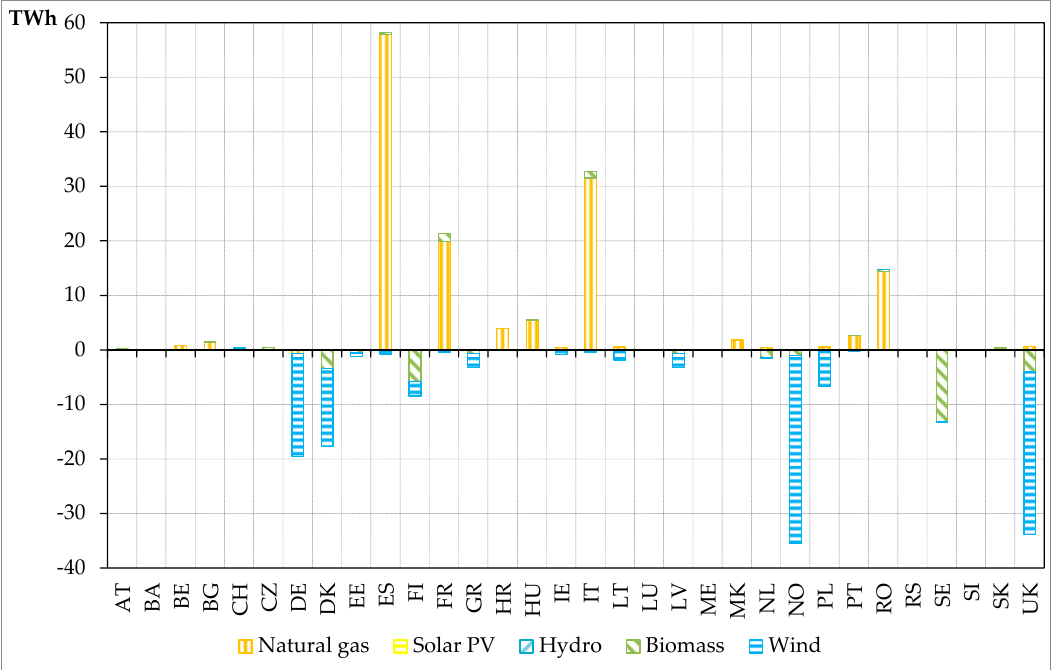
Figure 11. Change in electricity generation in 2050 due to lower connectivity levels.